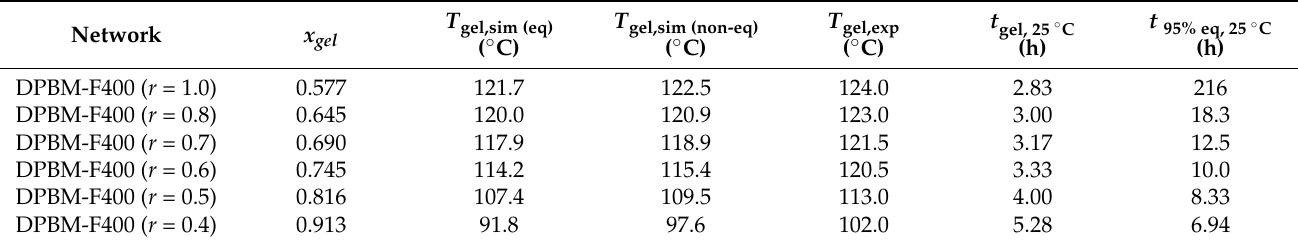
Table 4. Critical gel conversion, simulated equilibrium and non-equilibrium gel temperature, experimentally derived gelation temperature, simulation of gelation time and required time to reach 95% conversion at 25 ◦ C for RPN with different stoichiometric ratios r